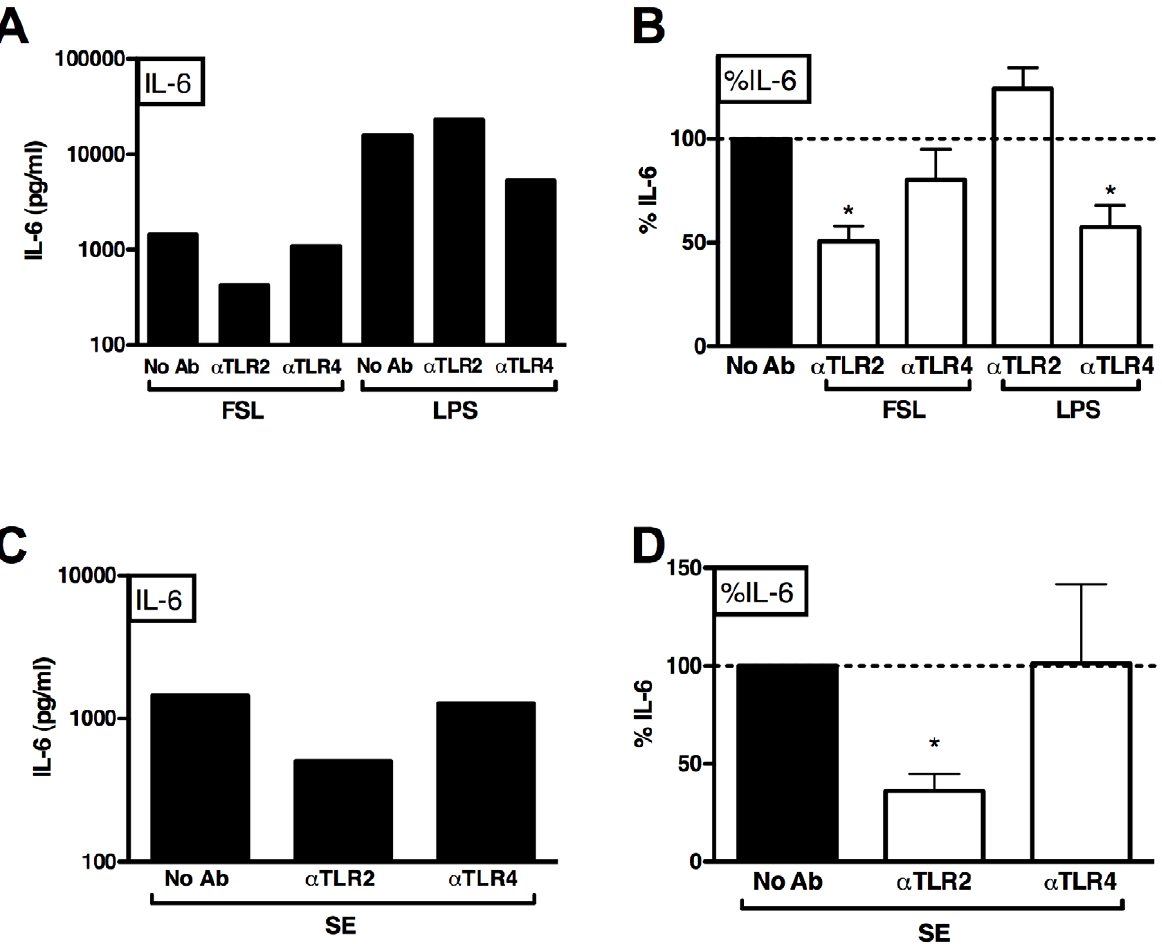
Figure 2. Neutralizing anti-TLR2 antibody inhibit SE-induced cytokine production in human blood. Blocking anti-TLR IgA Abs were added to human whole blood (10 m g/ml) 30 min prior to stimulation with SE (10 6 /ml) for 4 h and extracellular IL-6 measured by ELISA. (A) Anti-TLR2 Ab selectively inhibited FSL-, but not LPS-induced IL-6 production (representative of four similar experiments). (B) Composite analysis of inhibition expressed as %IL-6 production relative to control (no Ab); n=4; (C) Selective inhibition of SE-induced IL-6 by anti-TLR2, but not anti-TLR4 Ab (representative of 4 similar experiments). (D) Composite analysis of inhibition expressed as %IL-6 production, relative to control (no Ab). 1 sample-t- test vs. 100% (n=4); * p , 0.05.